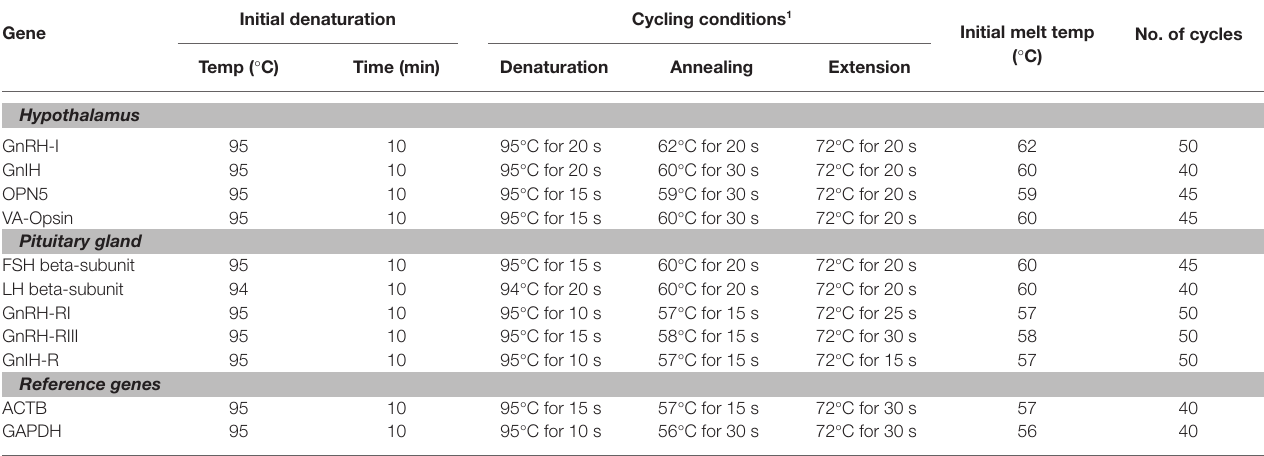
TABLE 2 | Cycling conditions for RT-quantitative PCR